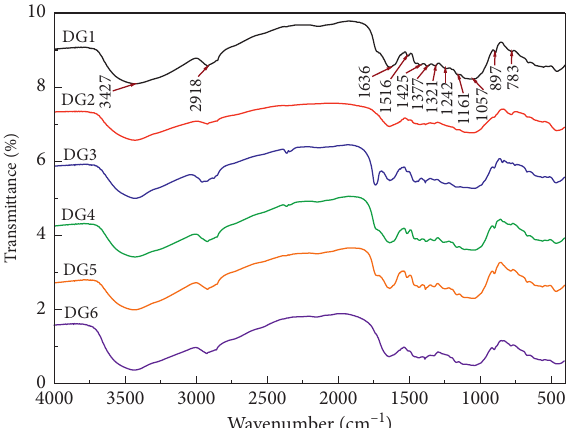
Figure 6: FTIR spectra of straw fibers modified with different methods.